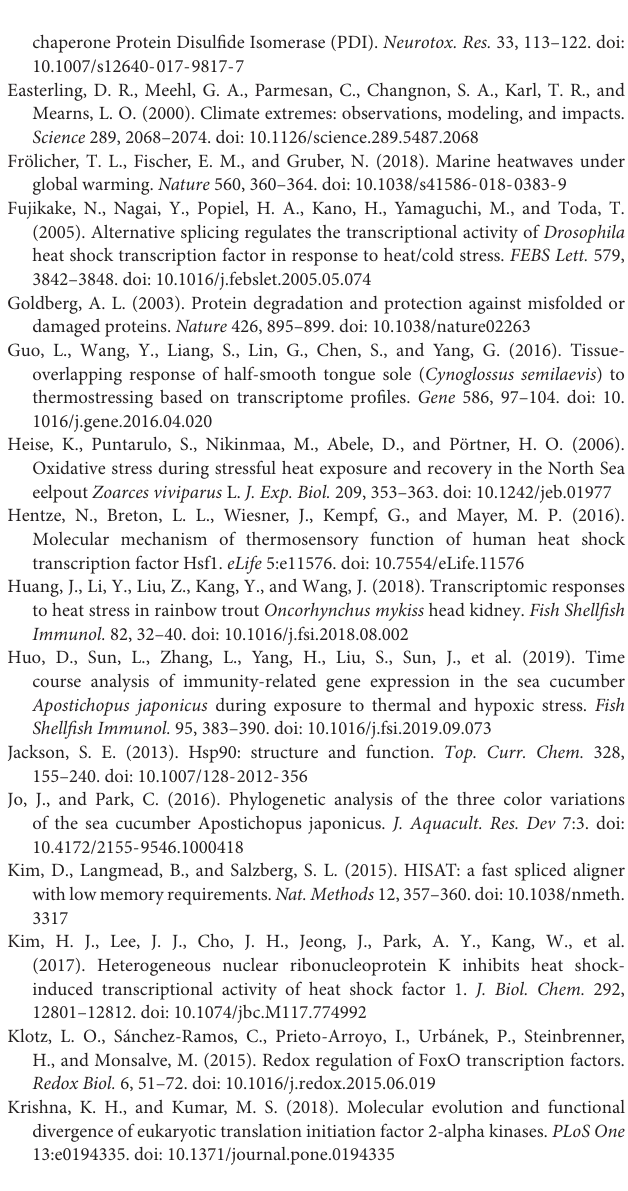
Supplementary Table 5 | Detailed information on significantly enriched GO terms. Supplementary Table 6 | Detailed information on significantly enriched